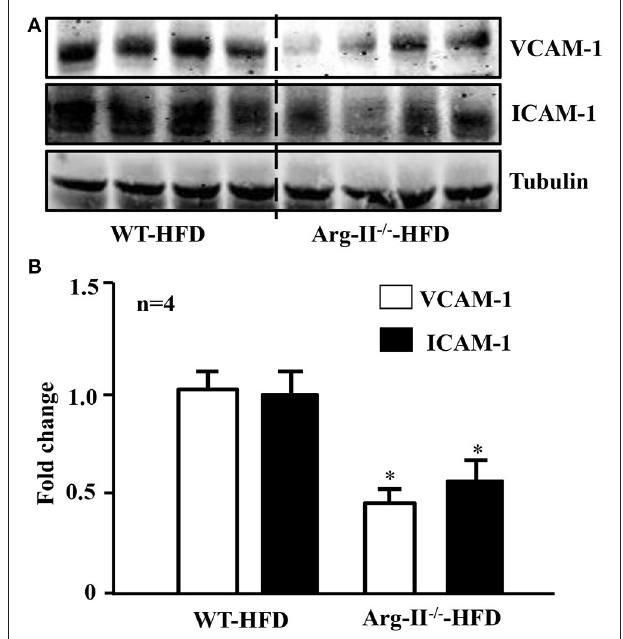
FIGURE 8 | Arg-II-deficiency reduces adhesion molecule levels in the kidney in obesity. (A) Immunoblotting analysis of VCAM-1 and ICAM-I expression in the kidney of WT and Arg-II − / − mice fed HFD. (B) Bar graphs show quantification of VCAM-1 and ICAM-I expression. n = 4, * p < 0.05 between indicated